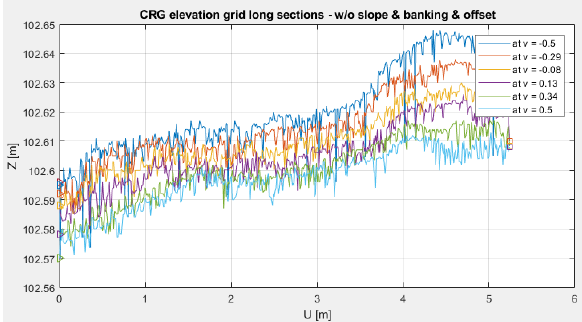
Figure 5. Longitudinal sections for a TLS data